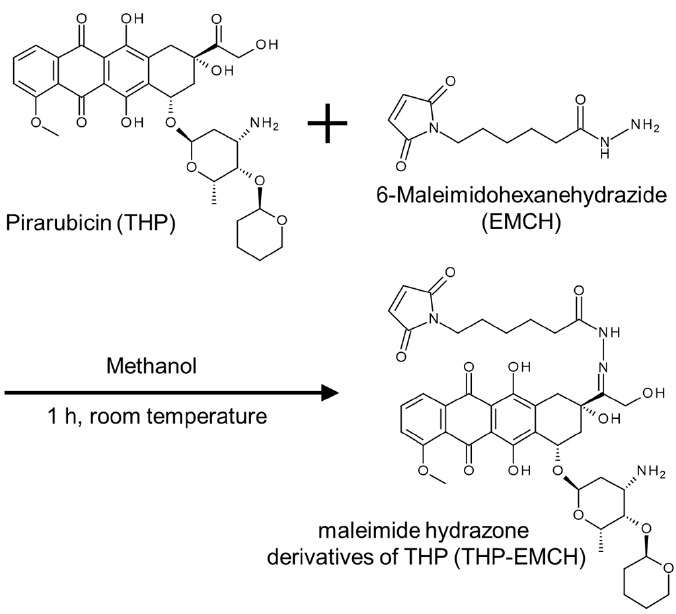
Figure 1. Synthesis of maleimide hydrazone derivatives of pirarubicin (THP) (THP-EMCH) using 6-maleimidohexanehydrazide (EMCH). Chemical structures and conjugation pathway.